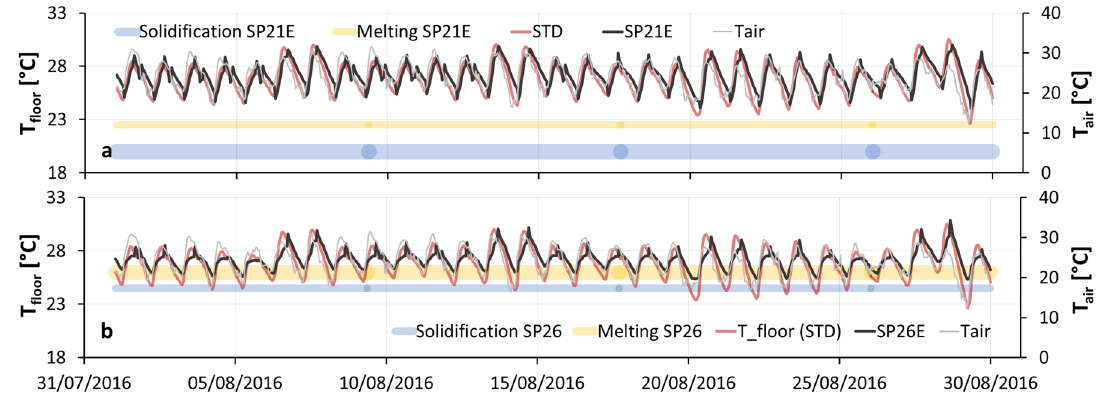
Figure 11. Floor temperatures compared to melting and solidification temperature range of PCM for the month of August in Rome: ( a ) SP21E; ( b ) SP24E.